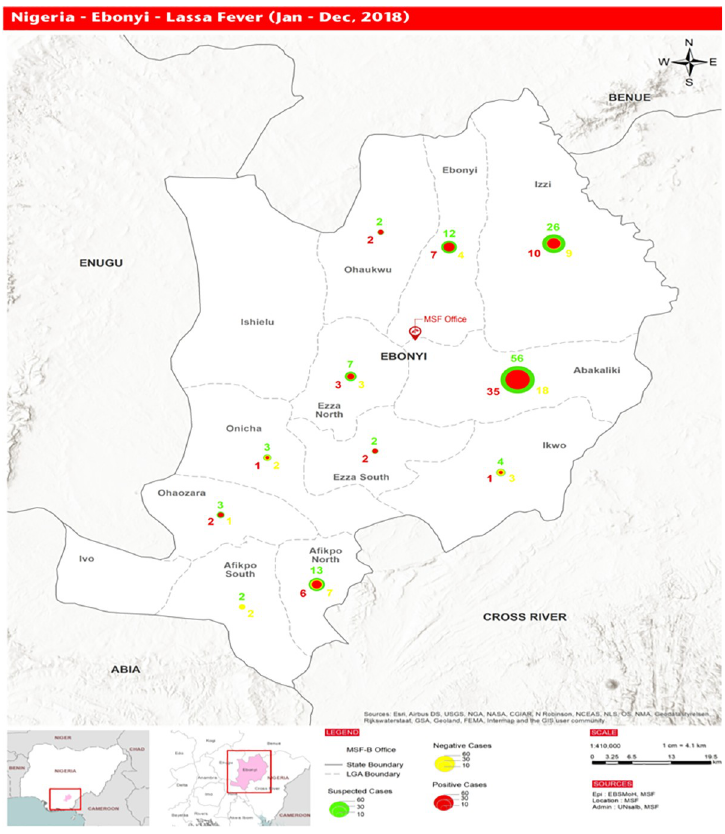
Fig 2. Map of Ebonyi State showing LGA’S affected by LF in 2018. Generated by Mede´cins sans Fronti è res, (MSF) Nigeria.